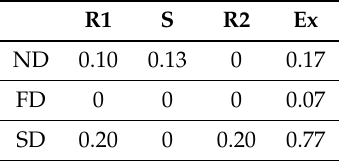
Table 7. EER (%) results for every type of signal under the same visit.